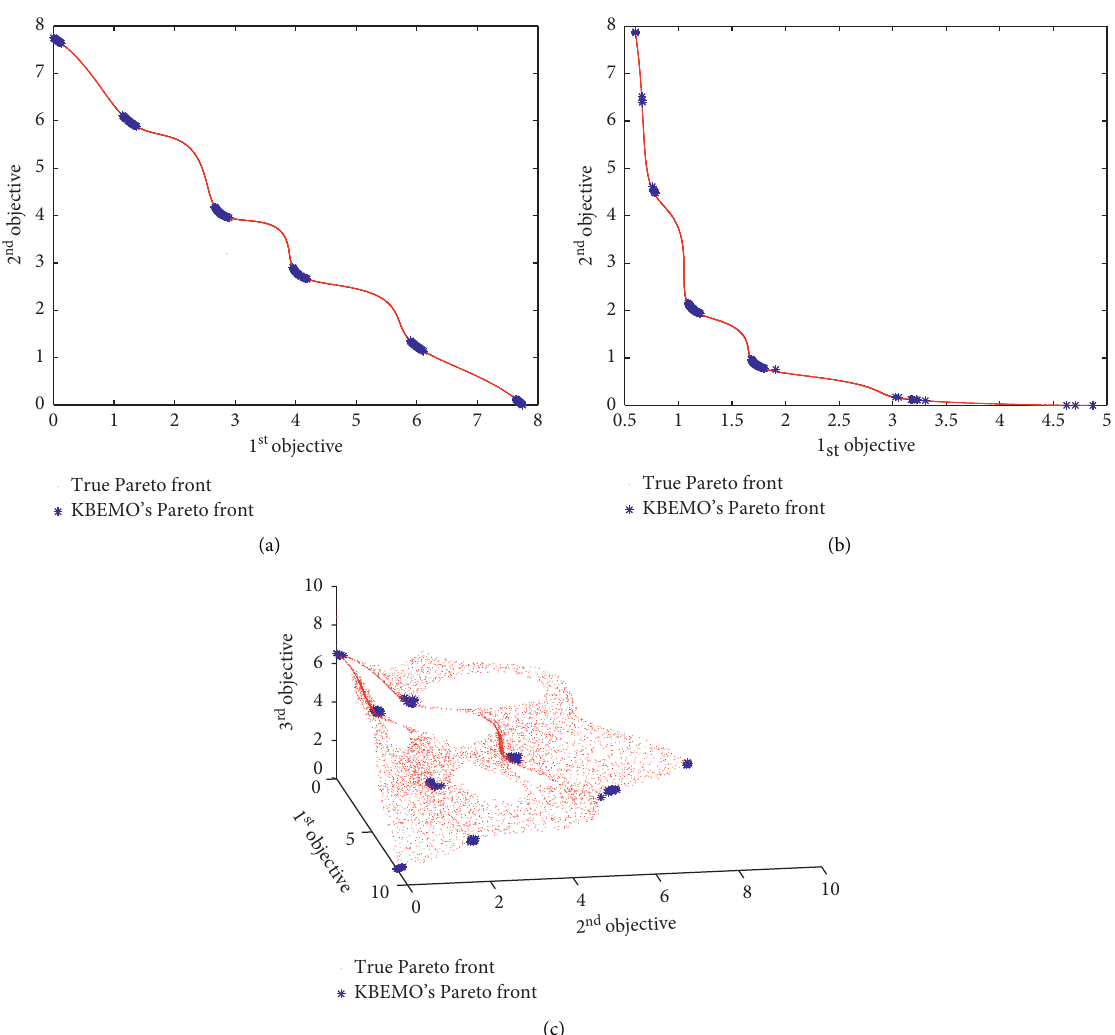
Figure 5: Pareto fronts obtained by KBEMO on knee test problems: (a) DEB2DK; (b) DO2DK; (c) DEB3DK.